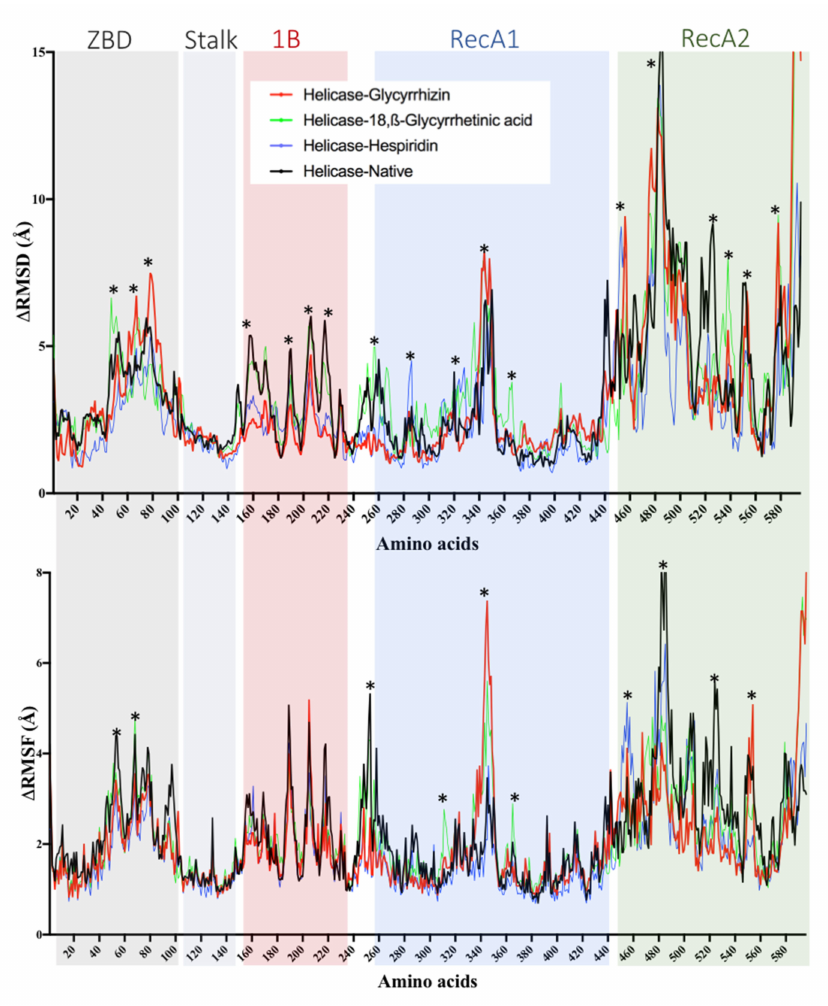
Figure 11. RMSD and RMSF calculated from 30 ns molecular dynamics simulation of Glycyrrhizin (red), Hesperidin (green), Baicalin (blue) in complex with SARS-CoV-2 RdRp. The residues with dynamic RMSD and RMSF are mentioned with